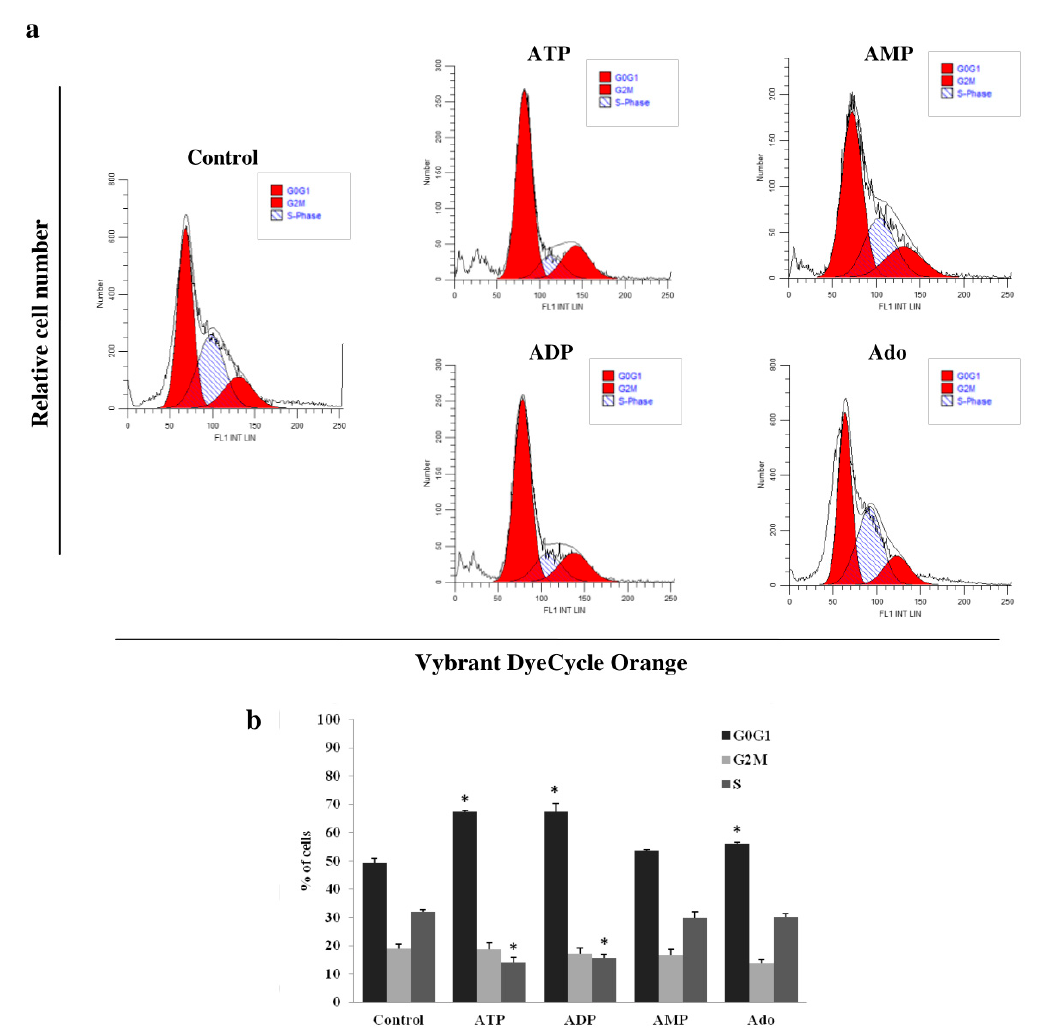
Figure 4. Effects of adenine nucleotides and adenosine (Ado) on the THP-1 cell cycle. ( a ) Representative flow cytometric analysis of THP-1 cells stained with Vybrant DyeCycle Orange after 72 h of incubation with 100 µM of adenine nucleotides or adenosine. ( b ) Changes in the percentage of cells in particular phases of the cell cycle (G 0 G 1 , S, and G 2 M) affected by ATP and ADP. Data are presented as the mean ± SD of three different experiments. * p < 0.05 compared to the unstimulated control cell culture.